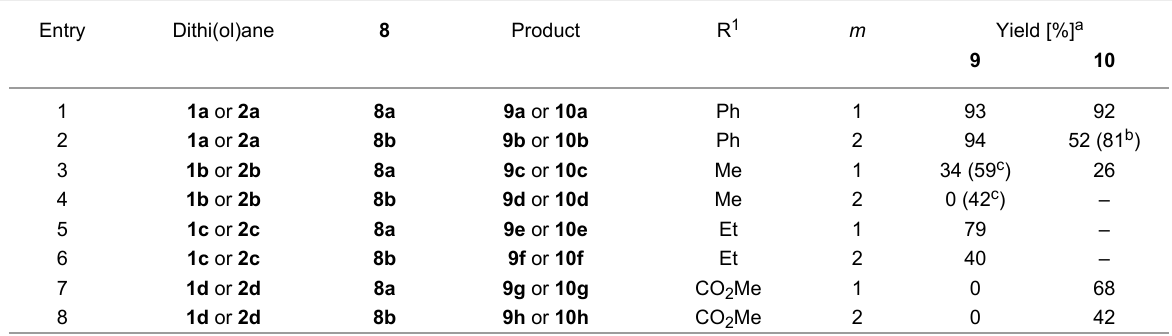
Table 2: Addition of dithi(ol)anylium TFBs 1a–d or 2a , b , d to ketones 8a or 8b .